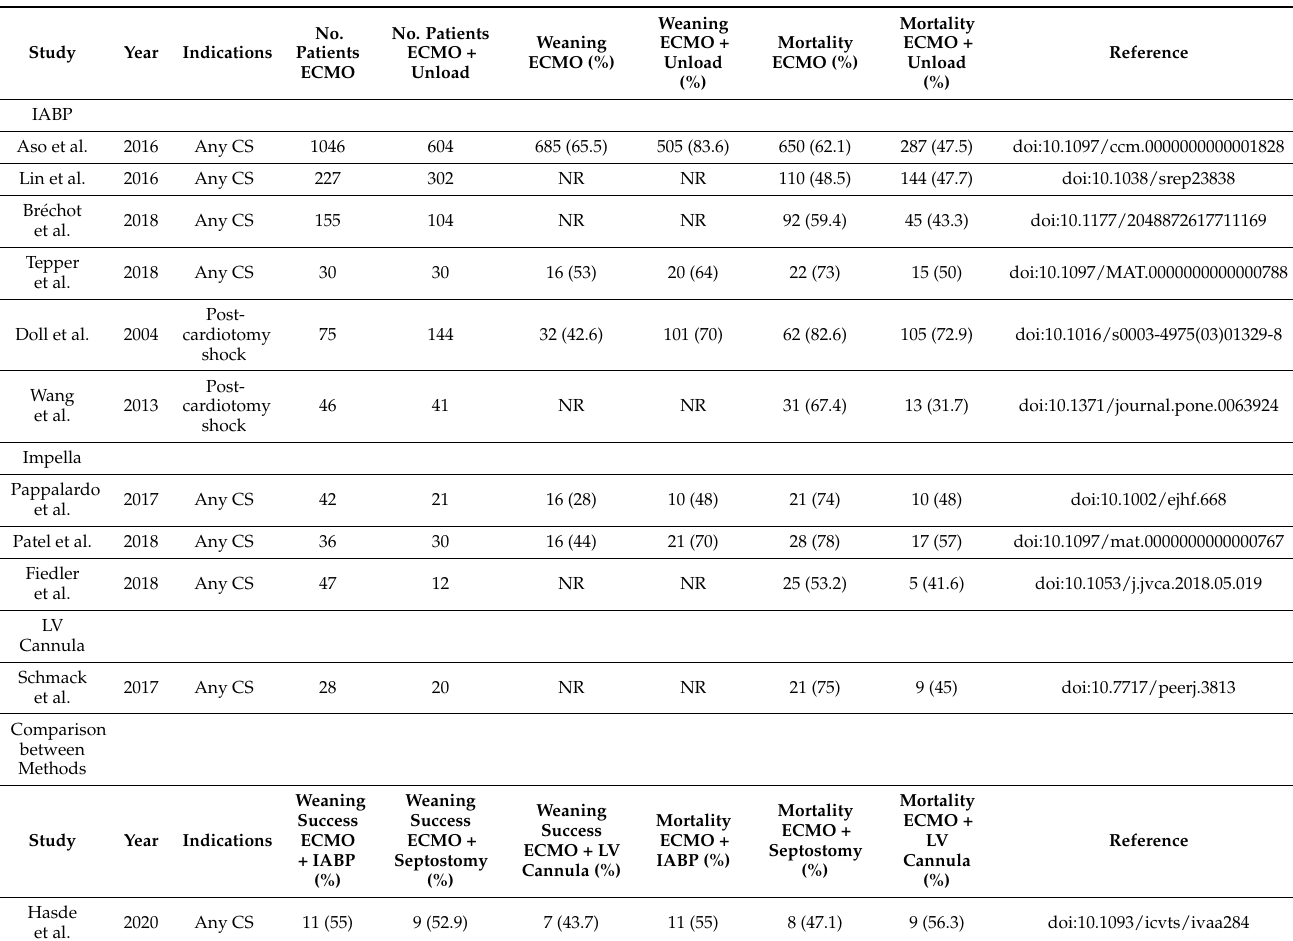
Table 3. Selected evidence for the use of LV unloading